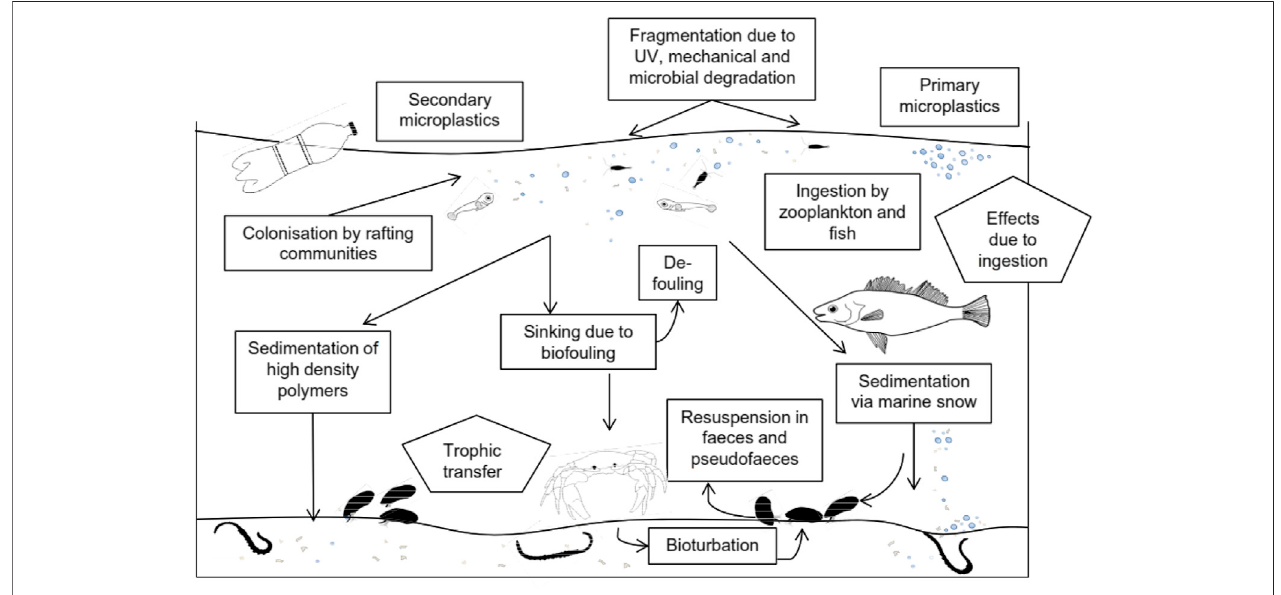
FIGURE 4 | Possible toxicokinetic routes for microplastic pollution on aquatic species (European Environmental Agency, 2019).